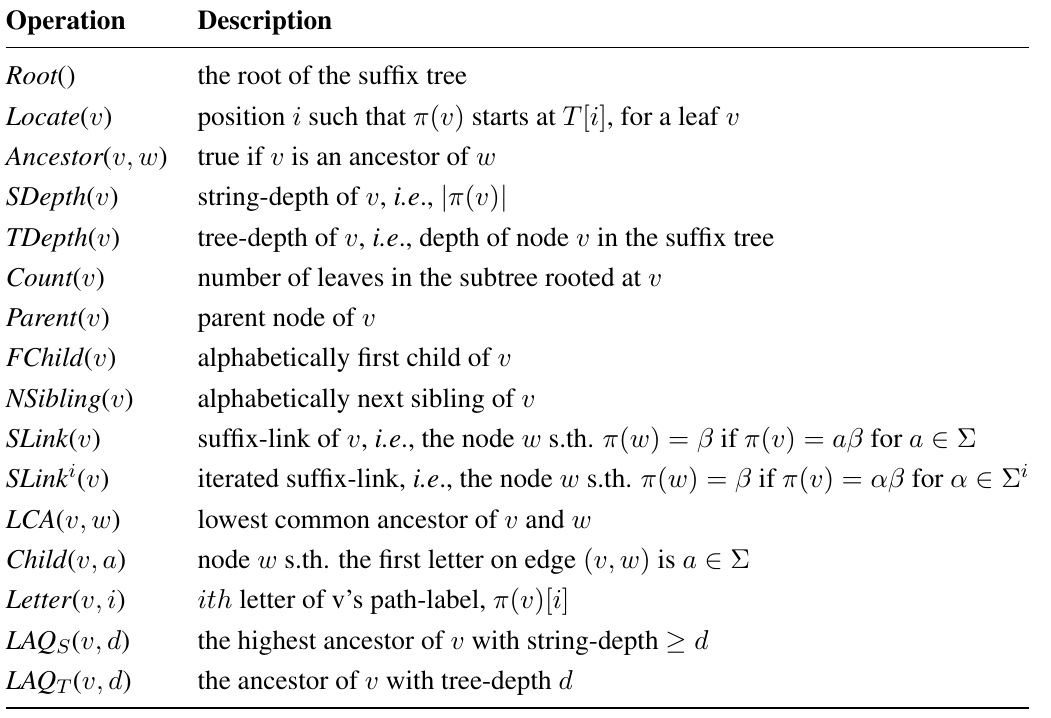
Table 1. Main operations over the nodes and leaves of the suffix